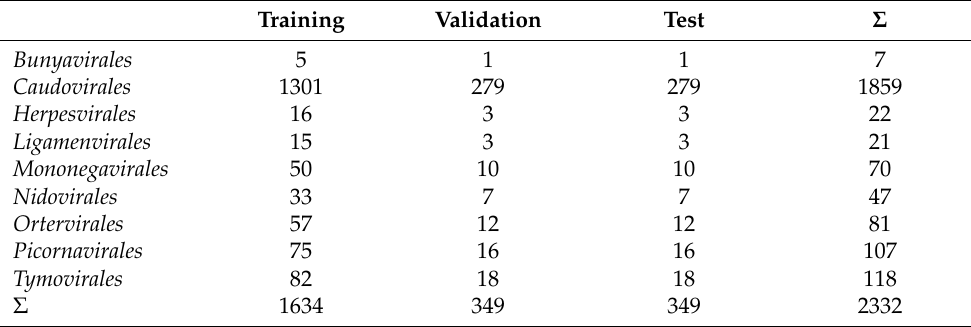
Table 2. Numbers of viruses in training, validation and test set. Step one of the sampling procedure was to randomly sample viruses and viral reads from each order without replacement and allocate them to training, validation and test set. A total of 70, 15 or 15% of sampled viruses are used for training, validation or test data,